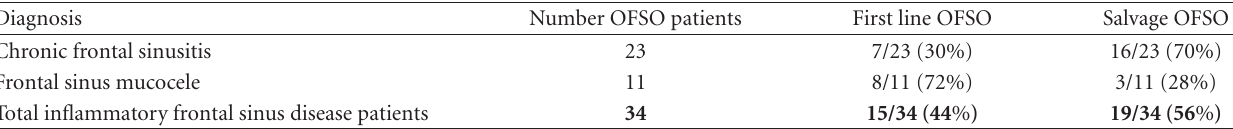
Table 1: The use of osteoplastic frontal sinus obliteration (OFSO) as first line or salvage therapy correlates with